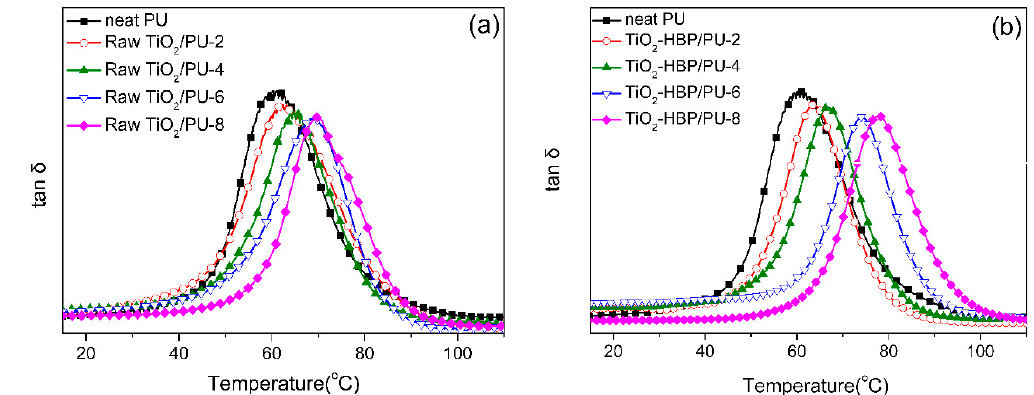
Figure 8. The loss factor curves of ( a ) raw TiO 2 / polyurethane (PU) nanocomposite coatings and ( b ) / PU nanocomposite TiO 2 -HBP/PU nanocomposite coatings. TiO 2 -HBP